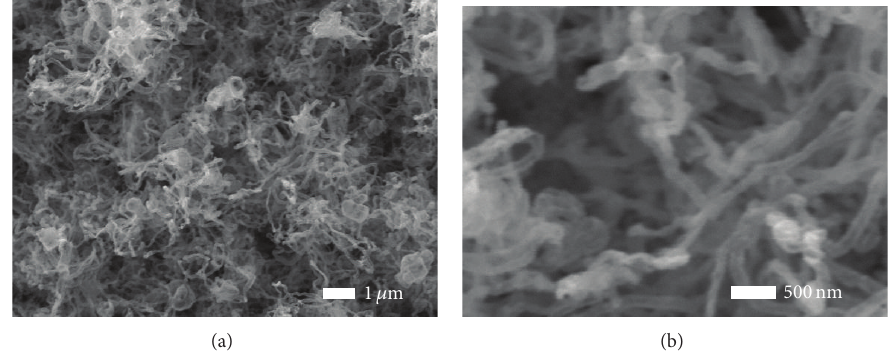
Figure 3: SEM images of ZnO nanorods: (a) low magnification image and (b) high magnification image. ZnO nanorods with diameters around 100 nm can be observed.